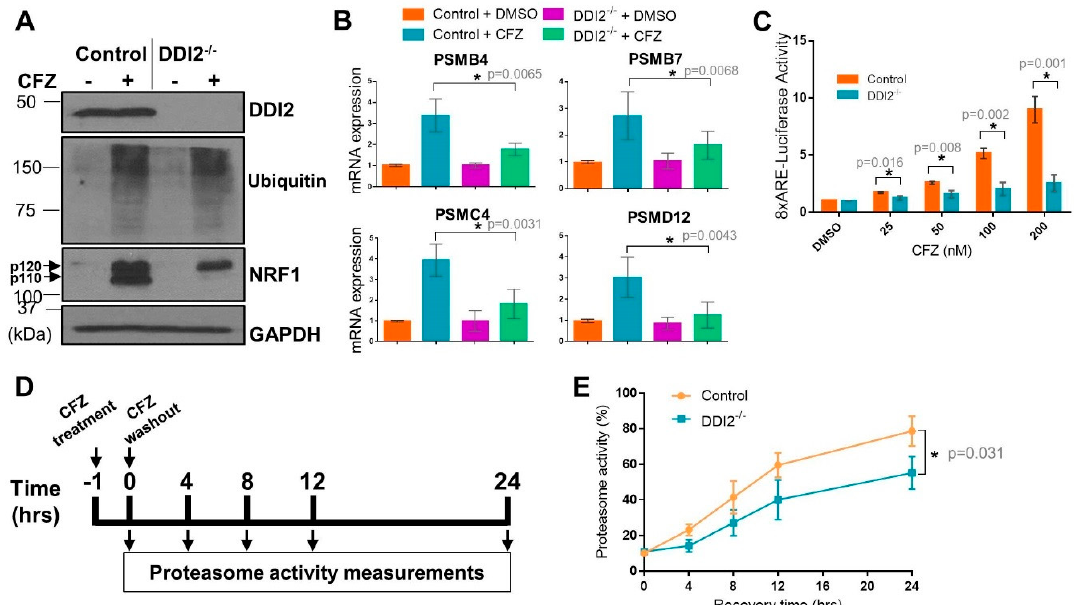
Figure 1. DDI2 is required for the proteolytic processing and transcriptional activity of nuclear factor erythroid derived 2-related factor 1 (NRF1). ( A ) NIH-3T3 control (expressing EGFP sgRNA) and DDI2 − / − cells were treated with 200 nM carfilzomib (CFZ) or equal volume DMSO for 4 h, and then analyzed by western blot using the antibodies indicated. GAPDH was used as a loading control. Blots shown are representative of three independent experiments. ( B ) NIH-3T3 control (expressing EGFP sgRNA) and DDI2 − / − cells were treated with 200 nM CFZ or equal volume DMSO for 8 h. RNA extracted from the cells was converted to cDNA, and then used for quantitative RT-PCR with primers for the genes indicated. mRNA levels of GAPDH were used for normalization. Error bars denote standard deviation ( n = 5 for PSMB4 and n = 6 for PSMB7 , PSMC4, and PSMD12 ). ( C ) NIH-3T3 control (expressing EGFP sgRNA) and DDI2 − / − cells were transfected with a construct containing 8 consecutive antioxidant response elements (8xARE (anti-oxidant response elements)) in a promoter region upstream of a firefly luciferase gene to measure NRF1 transcriptional activity and a human phosphoglycerate kinase promoter (ubiquitously expressed) upstream of renilla luciferase gene for normalization. At 48 h post-transfection, cells were treated with DMSO or indicated concentrations of CFZ overnight, after which dual luciferase assays were used to measure firefly and renilla luciferase activity. Normalized luciferase activity is shown. Error bars denote standard deviation ( n = 3). ( D ) Schematic of the proteasome recovery assay. ( E ) NIH-3T3 control (expressing EGFP sgRNA) and DDI2 − / − cells were treated with 50 nM CFZ for an hour, after which the drug was washed out with PBS and cells were allowed to recover in normal media. Proteasome activity in the lysates was measured at the indicated time points. The results were normalized to the DMSO-treated control. Error bars denote standard deviation ( n = 3). Significance ( p value < 0.05) is denoted by